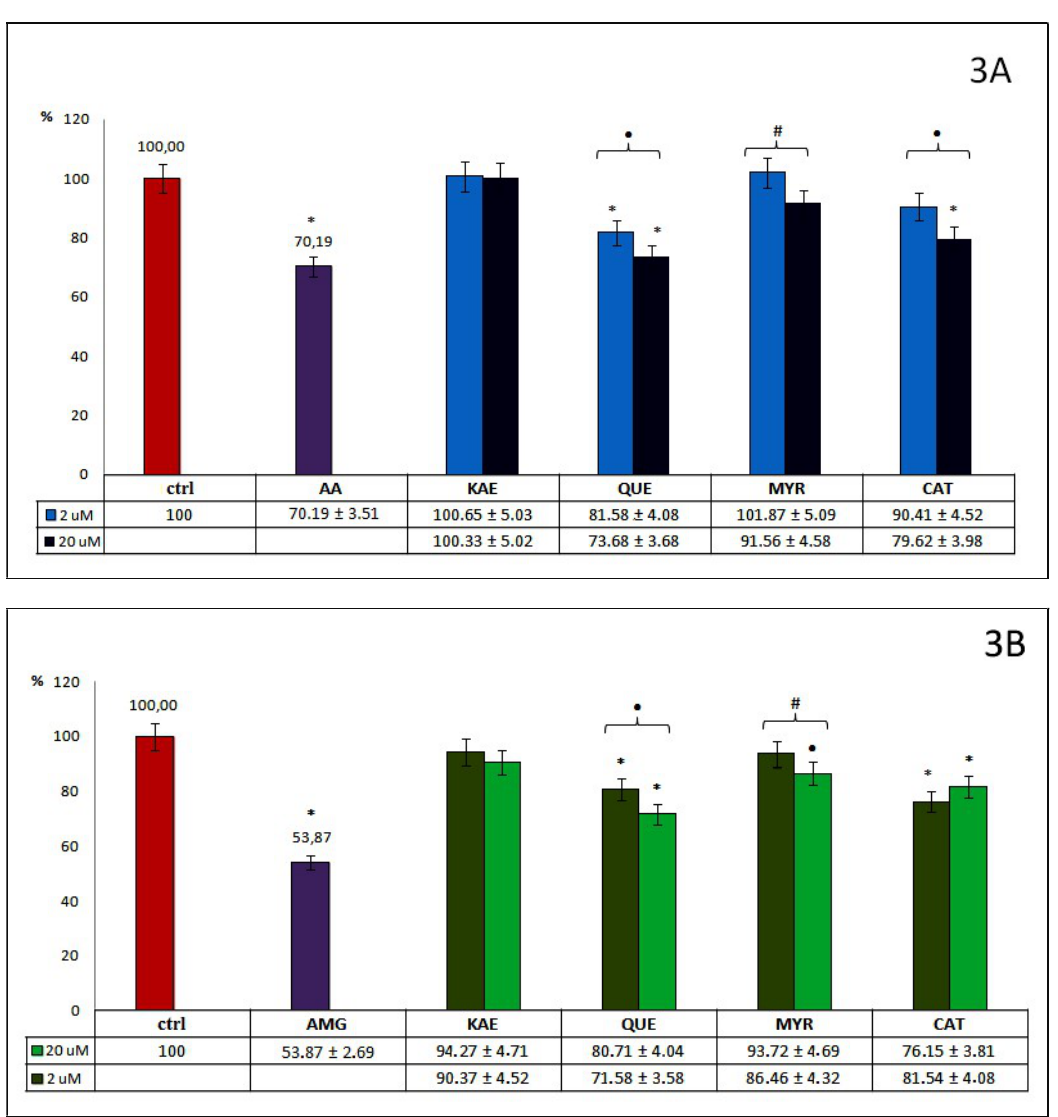
Figure 3. Percentage of AOPPs ( 3A ) and AGEs ( 3B ) formation during the glycoxidation process in samples incubated with 2 and 20 µM of tested flavan derivatives (group 3.). Significant differences in comparison to (ctrl), as well as between both used concentrations, were expressed as: (*) p < 0.001, (•) p < 0.01, (#) p < 0.05.